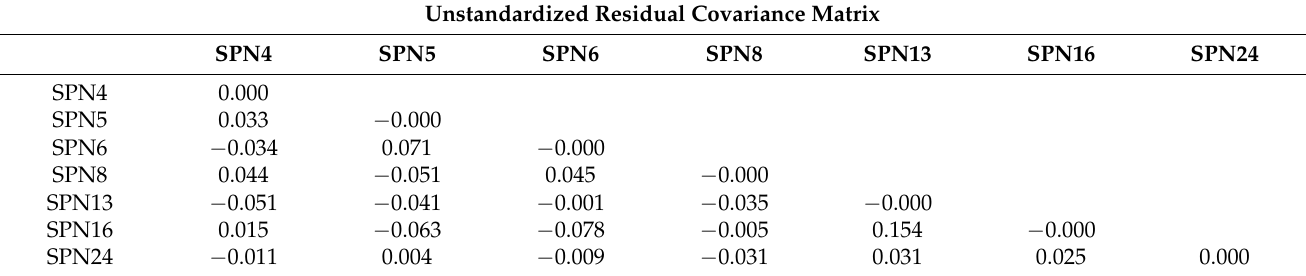
Table 8. Stakeholders participation (SPN)